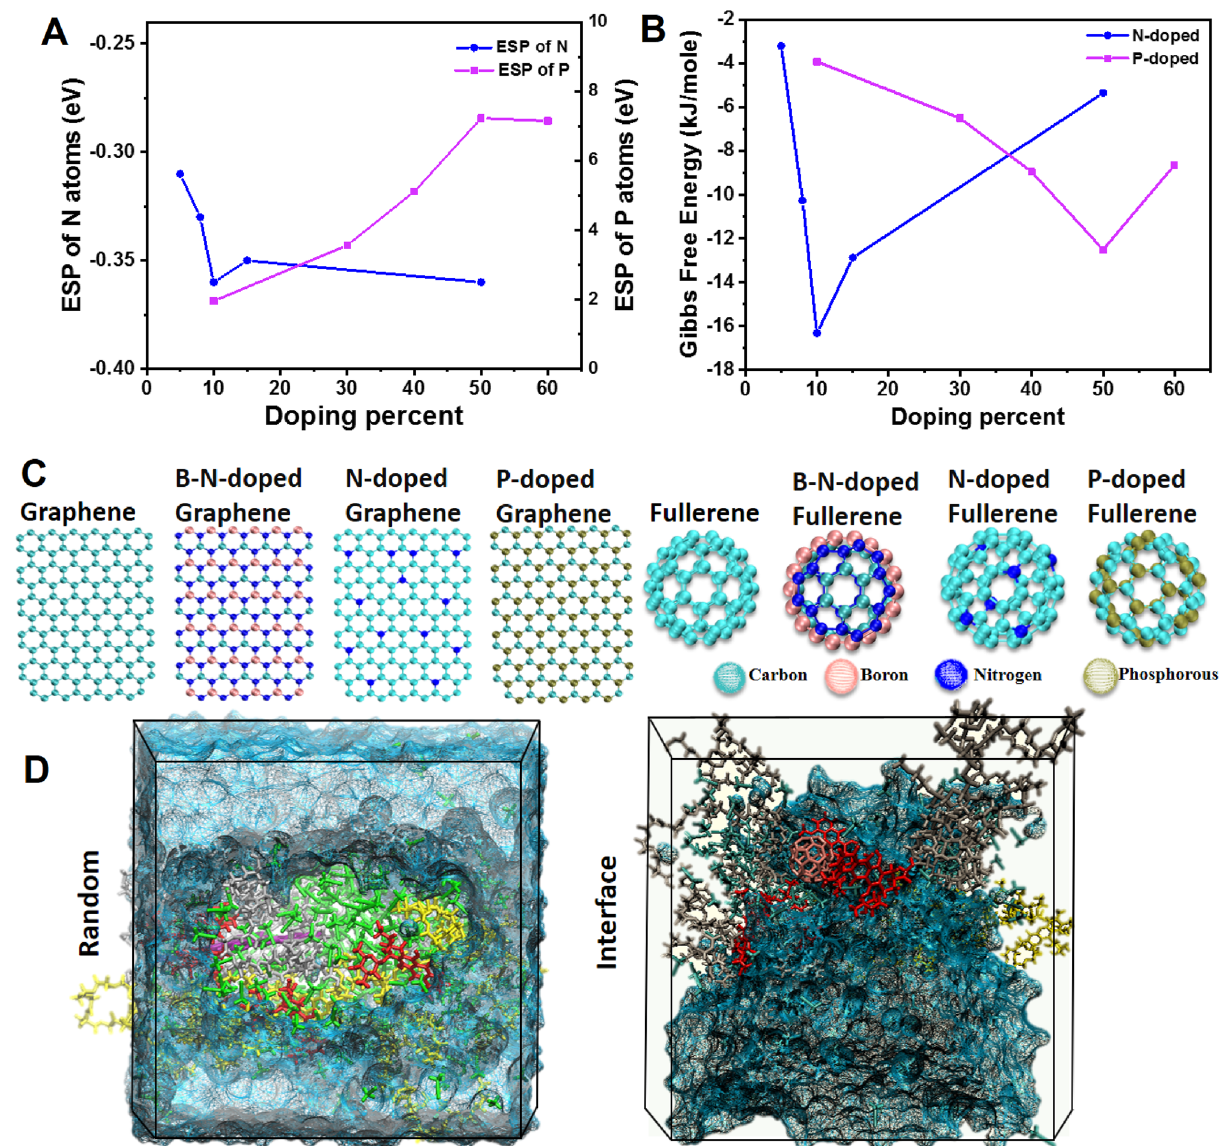
Figure 1. (A) Charge transfer of N- and P-doped graphene. ( B) Gibbs free energy results for the self-assembly process of polymers in the presence of doped graphene with varying amounts of doped molecules. Consistent with part A, the highest charge transfer in the structure leads to the formation of the most stable polymeric NPs. ( C) The molecular structure of carbon nanomaterials used in the seeding of polymeric self assemblies. ( D) Representation of the simulation methods; random and interface. Blue, green, and red molecules represent water, ACN, and DTX, while RF-conjugated polymer chains are yellow and PLGA-PEG strands are grey. The graphene nanosheet is purple (random method) and fullerene is pink (in the interface method).